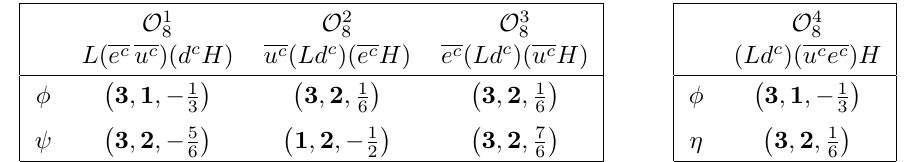
Table 5 . Minimal UV completions of operator are vectorlike